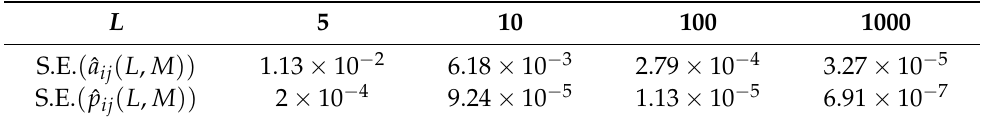
Table 7. Squared errors (S.E.) for the estimators of a ij and p ij in the case of censoring at the beginning and/or at the end, for various values of L .